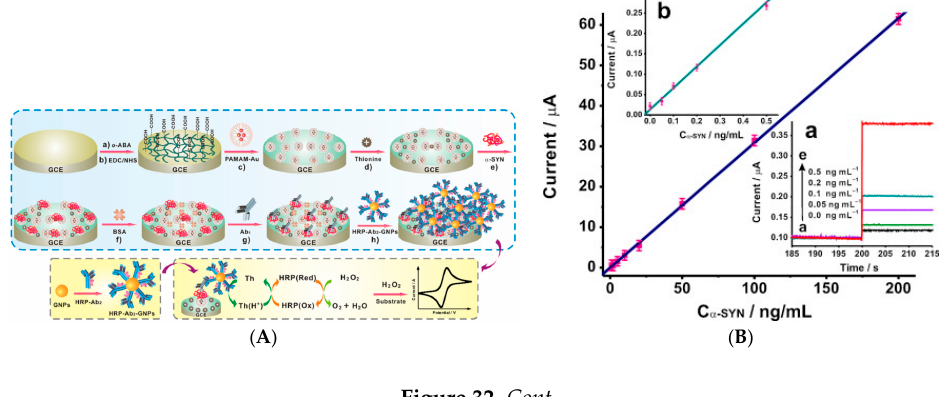
Table 9. Figures of merit of selected immunosensors using magnetic